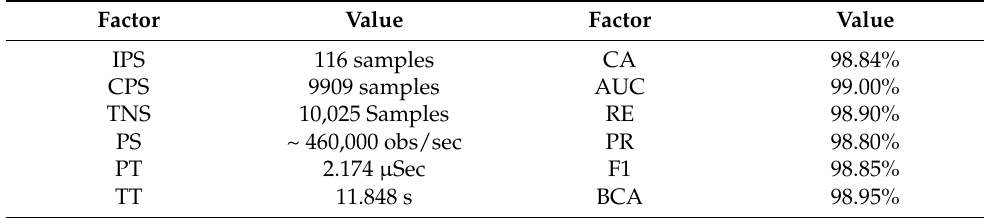
Table 3. Summary of experimental evaluation factors for the proposed system.